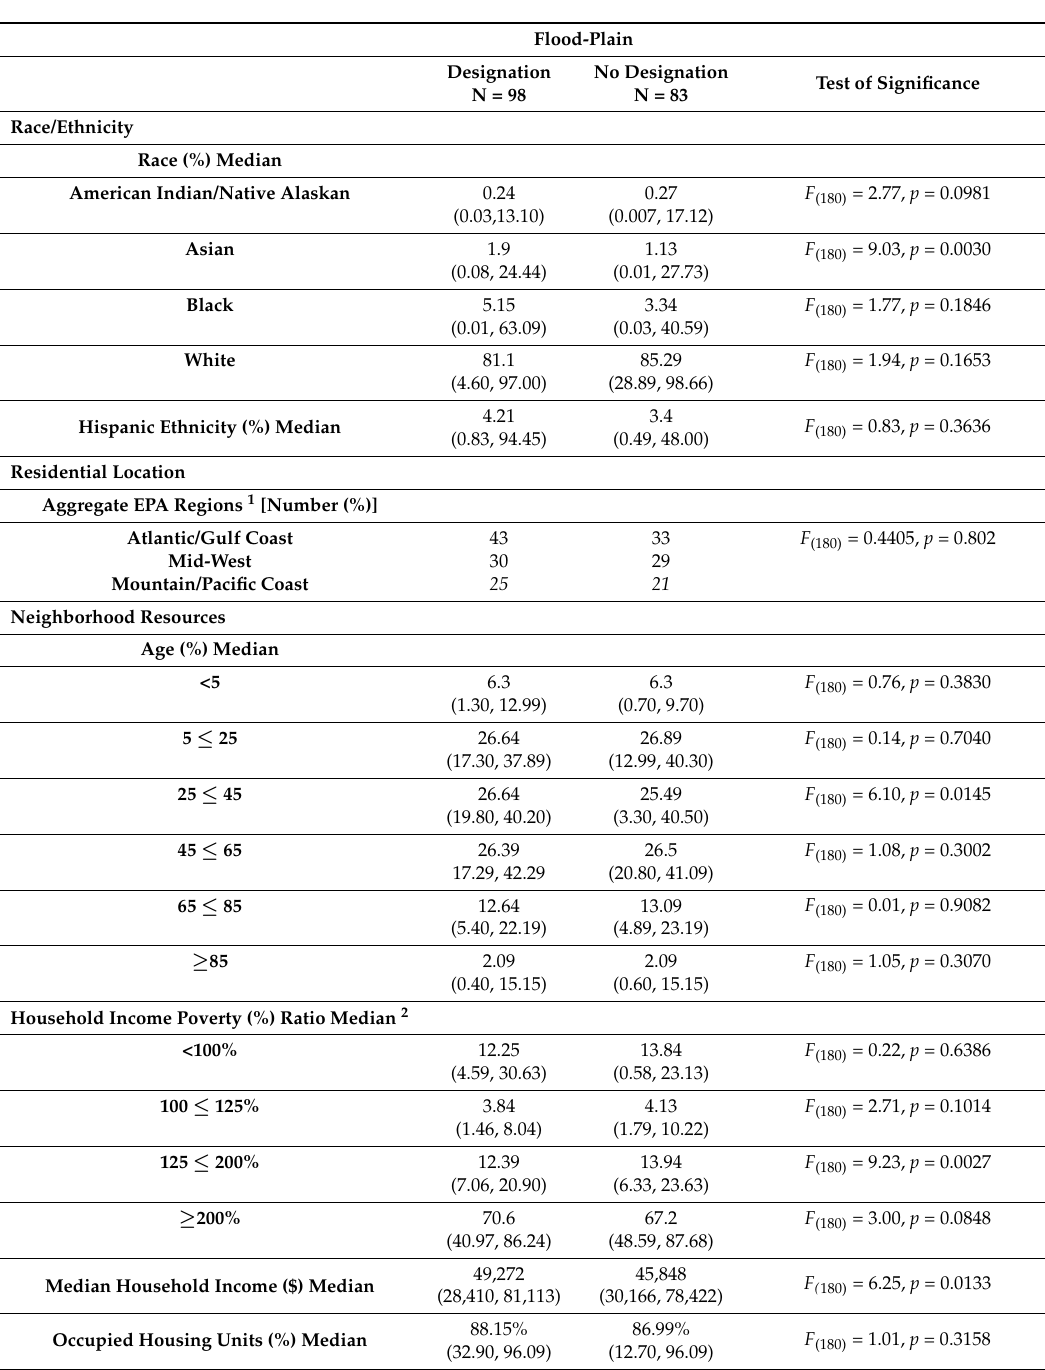
Table 3. County race/ethnicity, residential location, neighborhood resources, community stress, and structural factors by flood-plain